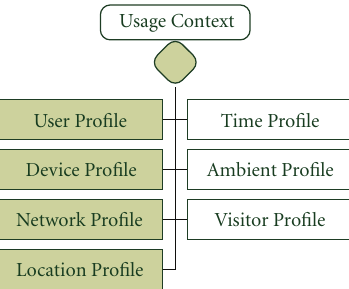
Figure 1: General usage context model for our context-aware multimedia